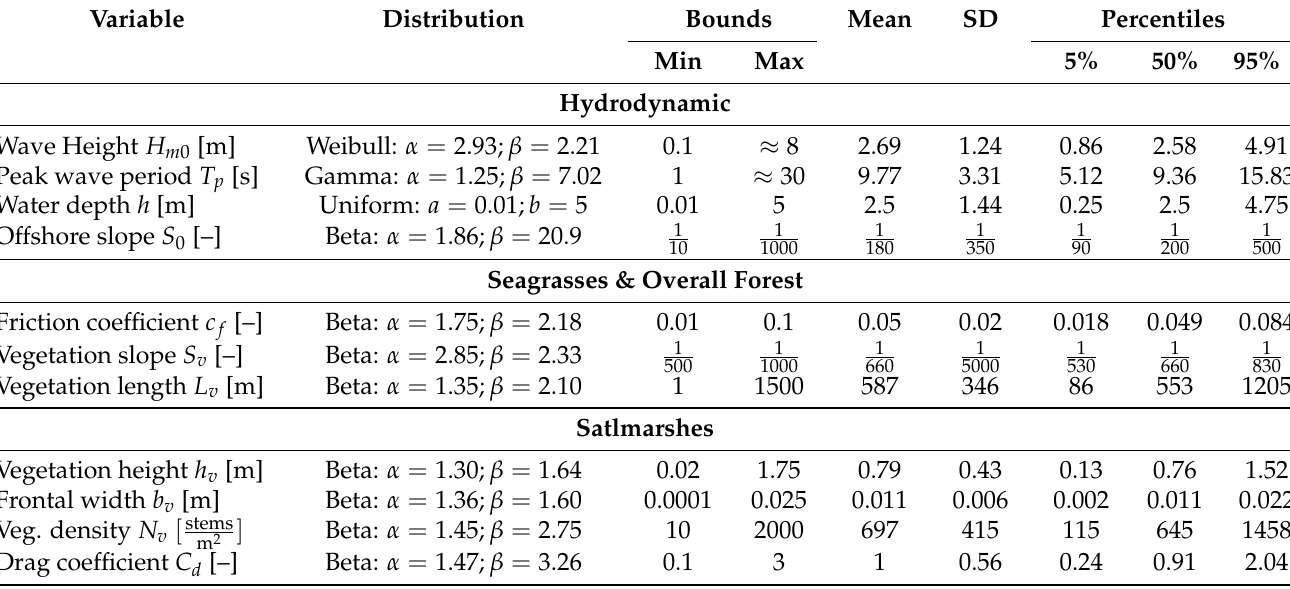
Table A1. All random variables with their distribution details used in stochastic